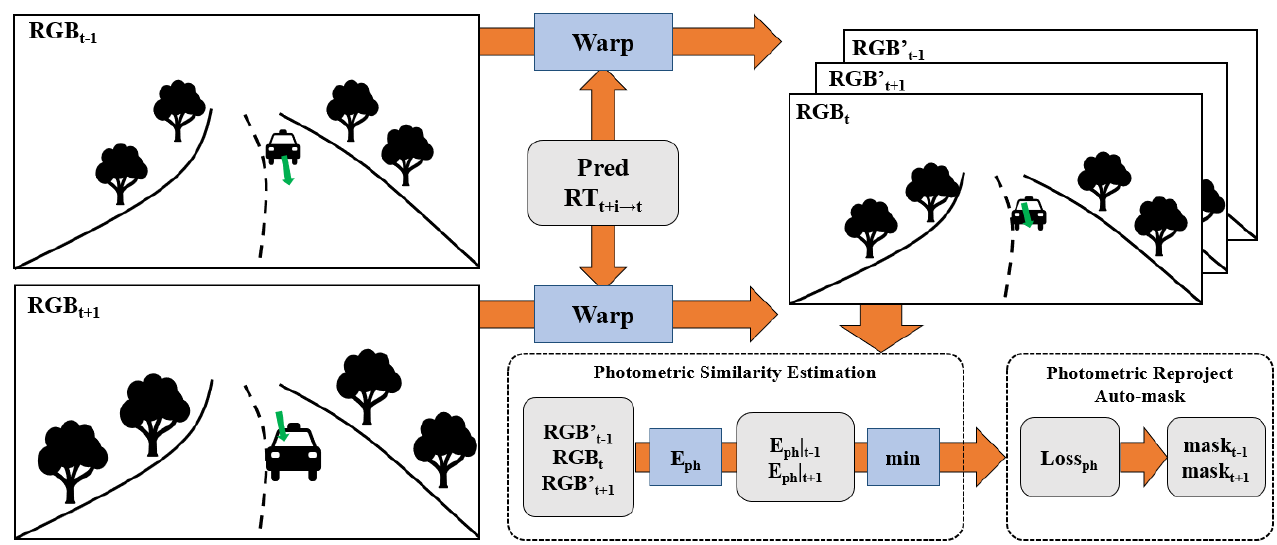
Figure 3. Warp RGB t + i to RGB (cid:48) with pose ( R , T t + i → t ) and completion depth ( Pred ), then generate t + i the automatic photometric reprojection